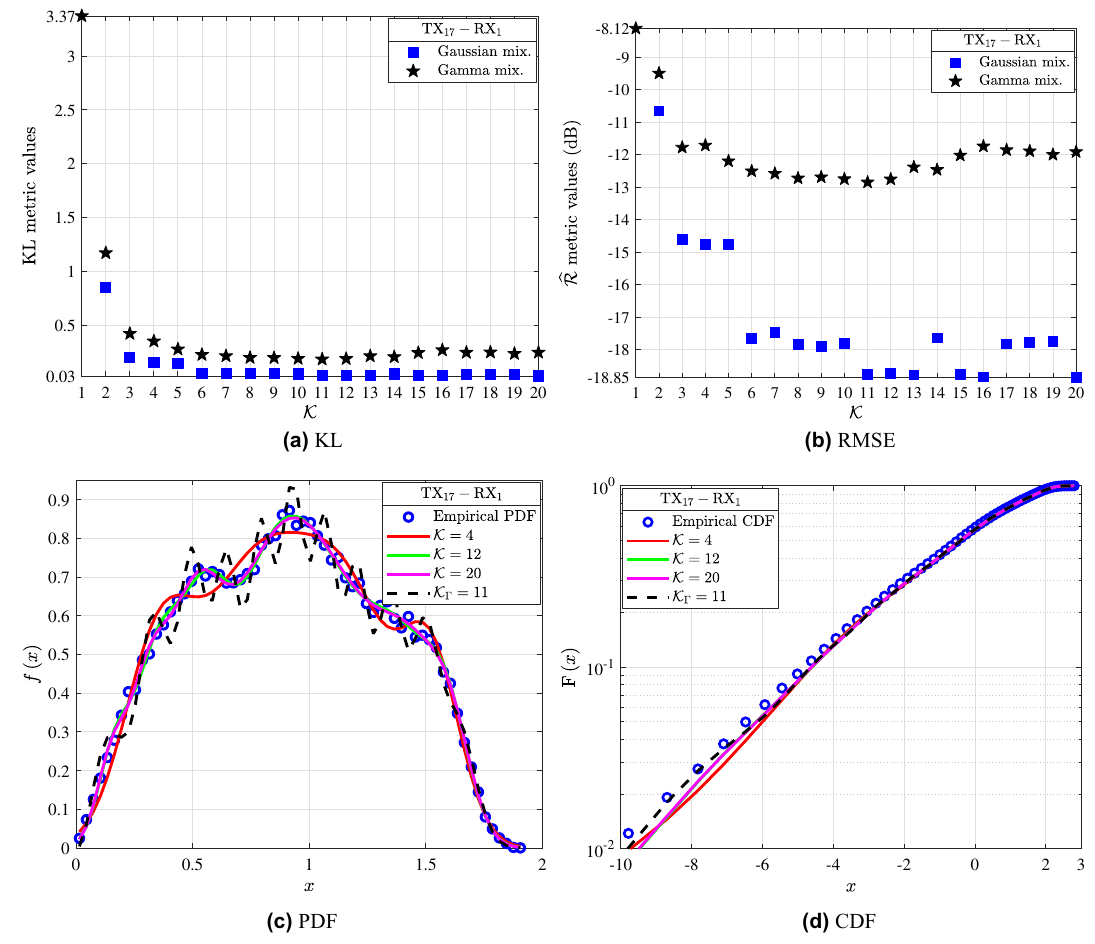
RX 1 : ( a ) KL and ( b ) R metrics for different values of K . ( c ) Fitting of the PDF and ( d ) CDF Figure 5. TX 17 − analytical GM and MG expressions to the empirical channel gain (cid:31) R 15.17 dB . = − Figure 2c and d serve as an illustrative example of the fitting achieved by the analytical GM expressions with RX 2 , respectively. RX 1 and TX 28 different K to the empirical channel gain PDFs and CDFs for the links TX 1 − − Specifically, the blue circles represent the empirical channel gain distributions of the investigated links, while RX 2 , RX 1 and TX 28 the continuous and dashed lines stand for the fitted GMs of different K for the links TX 1 − − respectively. Note that, unless otherwise is stated, the continuous and dashed lines of the same color denote GMs with the same K . By taking into account the KL and RMSE values of Table 1 and by examining the fitting of the PDFs and CDFs of the GMs to the empirical channel gain distributions of Fig. 2c and d, it can be ascertained that